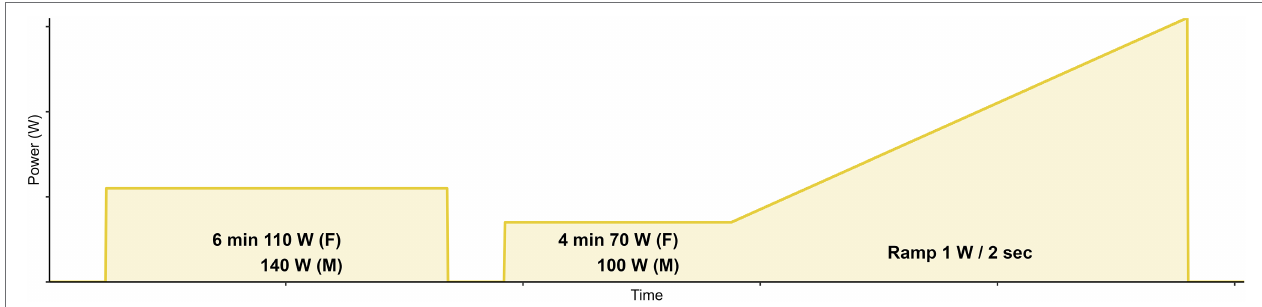
FIGURE 1 | Ramp exercise protocol. An initial baseline warm-up of 6 min at a moderate PO of either 110 W (females) or 140 W (males) was performed. It was then followed by 4 min at 70 W (females) or 100 W (males), before the continuous ramp commenced at 1 W per 2 s. Cessation of exercise was determined by the point at which the participant cadence went down by more than 10 revolutions per minute from their self-selected